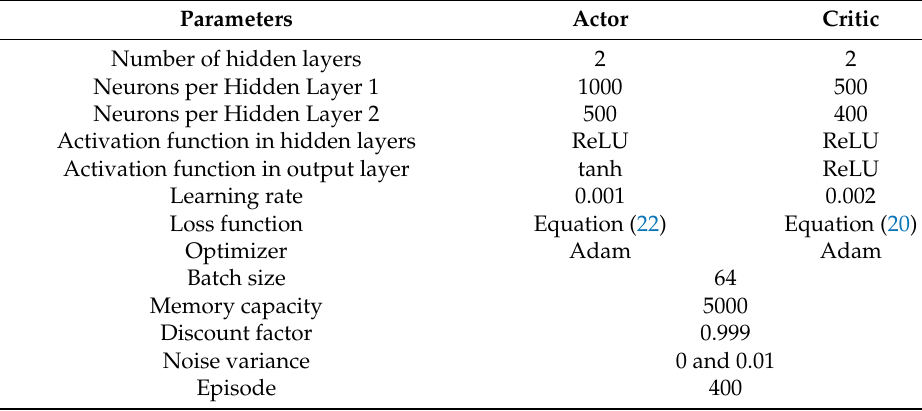
Table 4. Parameters for the actor and critic